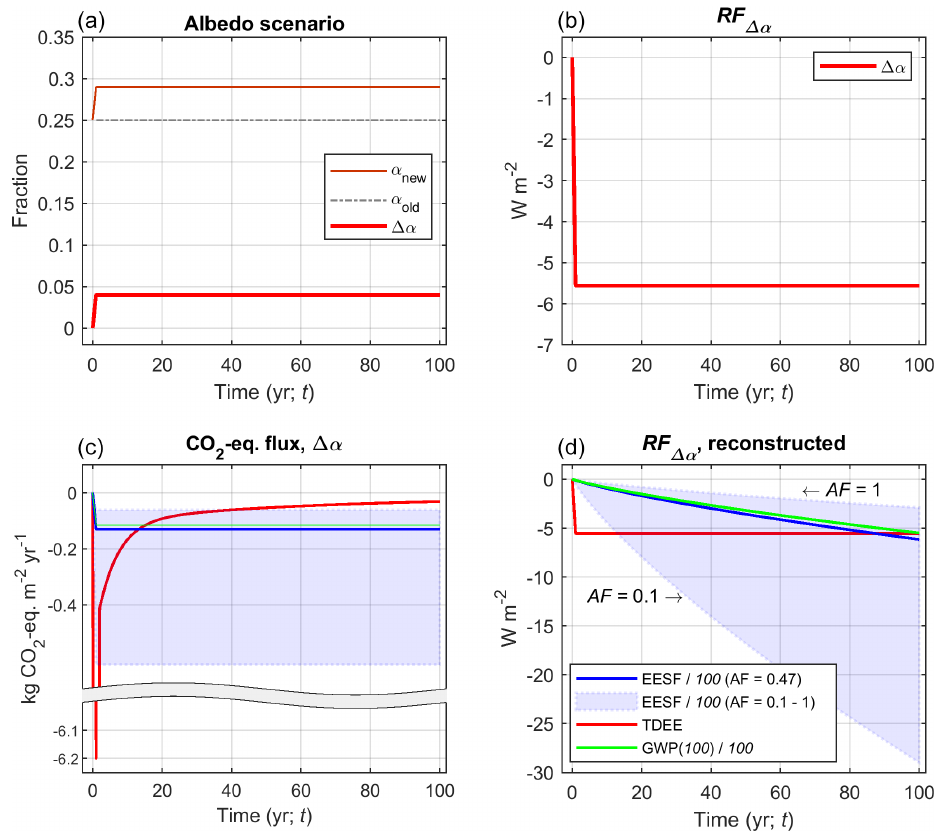
Figure 3. Example application of metrics yielding a complete time series of CO 2 -eq . pulse emissions or removals. (a) Time-dependent local (cid:49)α scenario (“ (cid:49)α ” = α new − α old ). (b) The corresponding local annual mean instantaneous shortwave radiative forcing over time (RF (cid:49)α (t) ). (c) The derived metrics T DEE , GWP(100) / 100, and EESF / 100 for a range of airborne fractions (AF). (d) The reconstructed local annual mean RF (cid:49)α (t) based on the values shown in panel (c) and Eq. (4). Note that the legend in panel (d) also applies to panel (c)